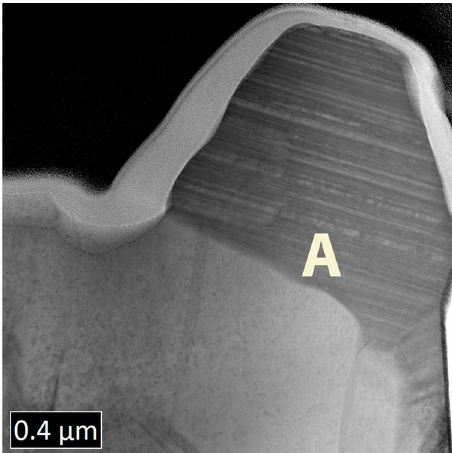
Fig. 2 Low-resolution cross-sectional TEM of a CdTe layer. A TEM image of a cross-section of thin fi lm photovoltaic device after a partial activation treatment with cadmium chloride. The grain marked A contains a high density of stacking faults terminating at a grain boundary and at a free surface. Stacking faults have been completely removed in adjacent grains. Stacking fault removal in individual grains is concerted and associated with the density of chlorine located in the grain